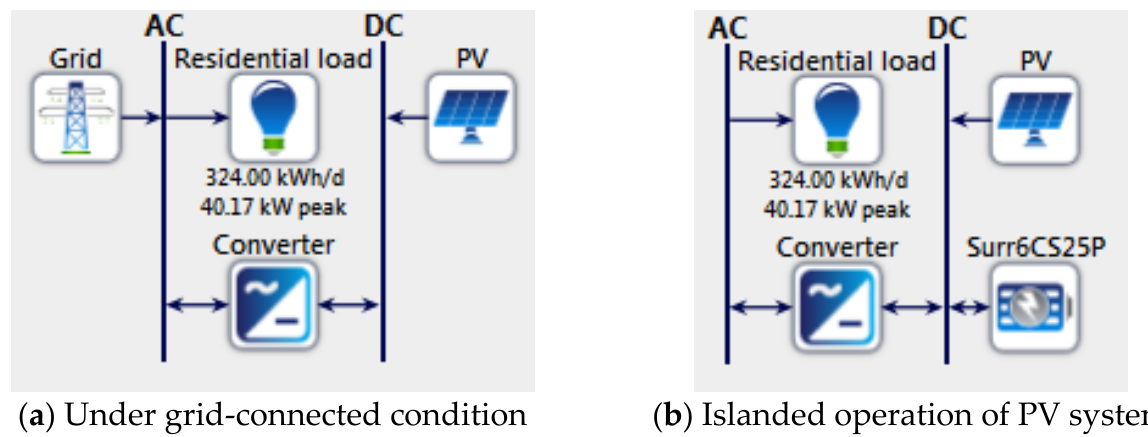
Figure 9. Schematic representation of the grid-tied/islanded supply systems in HOMER Pro for the investigated area.